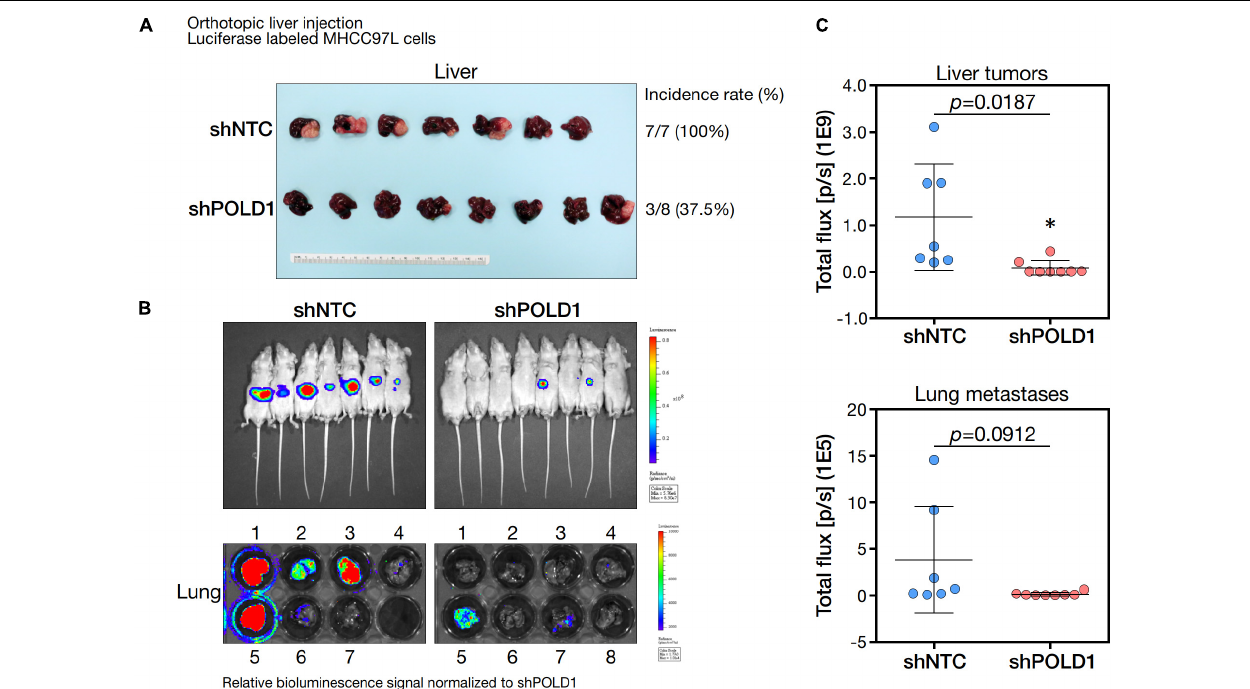
FIGURE 7 | Knockdown of POLD1 in MHCC97L-luc cells reduced tumor incidence, tumor sizes and lung metastases in orthotopic liver injection model. The in vivo functional role of POLD1 knockdown was evaluated as compared to the non-target control (NTC). Comparison was based on (A) tumorigenicity and (B,C) tumor size and lung